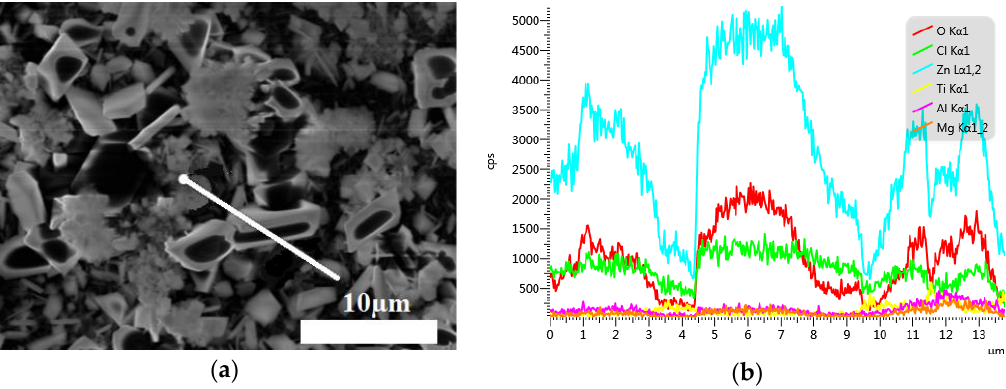
Figure 5. EDS line scan image of a sample immersed in dynamic salt water for 288 h.